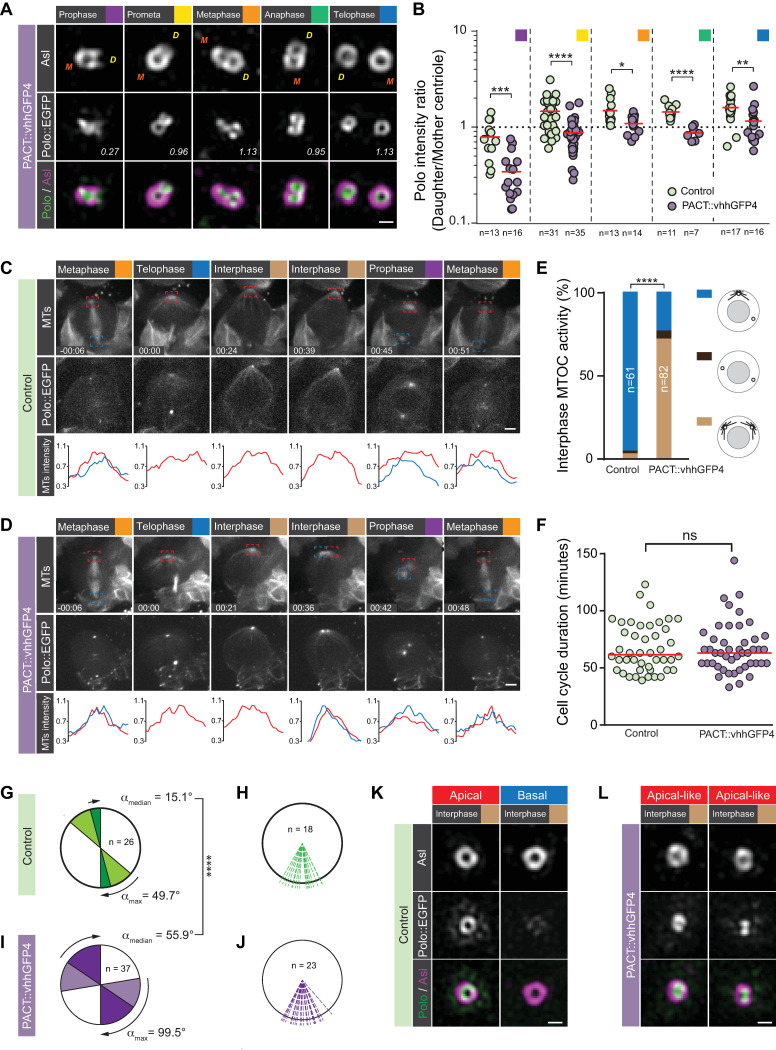
Establishment of centriolar asymmetry is required for biased interphase MTOC activity and centrosome positioning.(A) Representative 3D-SIM images of third instar larval neuroblast centrosomes, expressing Polo::EGFP (generated by CRISPR/Cas9) and the nanobody construct PACT::vhhGFP4. Polo::EGFP (middle: white; merge: green) expressing neuroblasts were stained for Asl (white; top row, magenta in the merge). Polo intensity ratios (daughter/mother centriole) are plotted in panel B for control (green dots) and PACT::vhhGFP4 (purple dots). These experiments were performed 2 times independently in parallel for both genotypes. Medians are shown in red. Mann–Whitney test: Prophase: control versus PACT::vhhGFP4: p = 3.11 × 10−4. Prometaphase: control versus PACT::vhhGFP4: p = 3.49 × 10−6. Metaphase: control versus PACT::vhhGFP4: p = 0.0222. Anaphase: control versus PACT::vhhGFP4: p = 6.28 × 10−5. Telophase: control versus PACT::vhhGFP4: p = 0.0077. (C) Representative live-cell imaging time series of a dividing control (Polo::EGFP, worGal4, UAS-mCherry::Jupiter) and (D) PACT::vhhGFP4 expressing (Polo::EGFP, worGal4, UAS-mCherry::Jupiter, and PACT::vhhGFP4) neuroblast. The microtubule marker (MTs, first row) and Polo::EGFP (generated by CRISPR/Cas9; second row) are shown for 2 consecutive mitoses. Microtubule intensity of the apical (red line and square) and basal (blue line and square) MTOC are plotted below. “00:00” corresponds to the telophase of the first division. (E) Bar graph showing the quantification of the MTOC phenotype in interphase (blue; wild-type–like asymmetry, dark brown; loss of MTOC activity, light brown; gain of MTOC activity). Fisher’s exact test: Polo::EGFP with and without PACT::VhhGFP4 expression; p = 1.786 × 10−19. Cell-cycle length is shown in panel F. The cell-cycle length in PACT::vhhGFP4 (purple dots) is not significantly different from the control (green dots): p = 0.9727 (Mann–Whitney test). Medians are shown in red. Panels G and I represent the spindle rotation between NEBD and anaphase. Medians are displayed in dark colors (green; control. Purple; vhhGFP4 expressing neuroblasts); p = 1.1125 × 10−8; n = 26 for control; n = 37 for vhhGFP. Maximum rotation is shown in light colors. Division orientation between consecutive mitoses shown for control (H) and PACT::vhhGFP4 (J). Panels K and L are representative 3D-SIM images of interphase centrosomes for control and PACT::vhhGFP4 expressing neuroblasts, respectively. The trapping of Polo::EGFP (generated by CRISPR/Cas9) with PACT::vhhGFP4 induces 2 identical apical-like (in respect to MTOC activity and Polo localization) centrosomes with a strong centriolar and PCM signal. The data presented for the live imaging here were obtained from 5 independent experiments. Cell-cycle stages are indicated with colored boxes. Yellow “D” and orange “M” refer to daughter and mother centrioles based on Asl intensity. Time stamps are shown in hh:mm and scale bar is 0.3 μm (A, K, L) and 3 μm (C, D), respectively. Numerical data for panels B, E, F, G, H, I, and J can be found in the file S1 Data.xlsx. Asl, Asterless; EGFP, enhanced green fluorescent protein; MTOC, microtubule organizing center; NEBD, Nuclear envelop break-down; PACT, Pericentrin-AKAP-450 containing targeting; PCM, pericentriolar material; 3D-SIM, 3D structured illuminated microscopy.